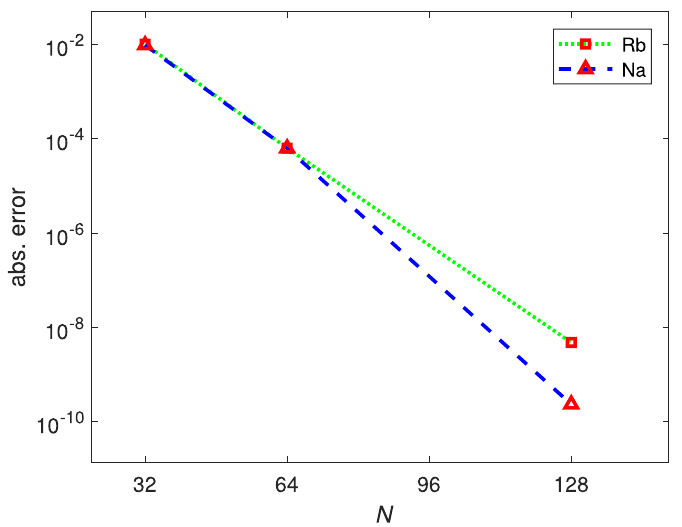
87 Rb 23 Na and